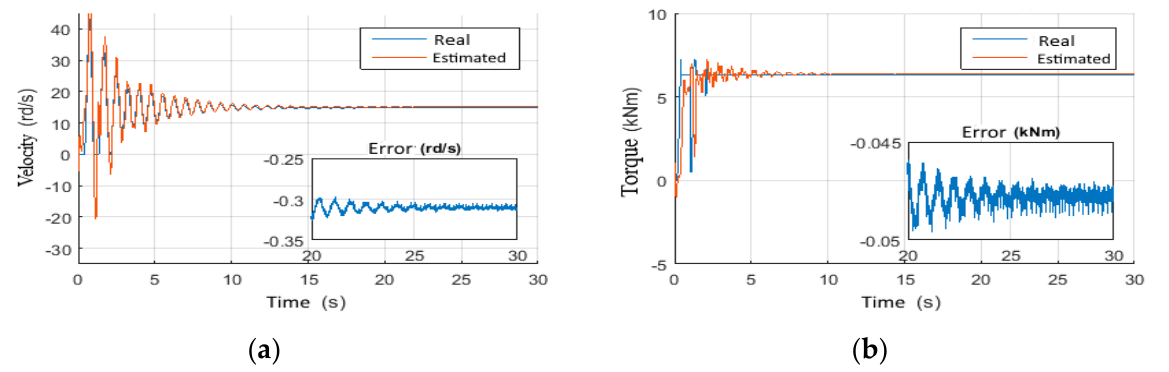
Figure 20. Noises on Top drive measurements, ( a ) Rotational velocity, ( b ) The current.